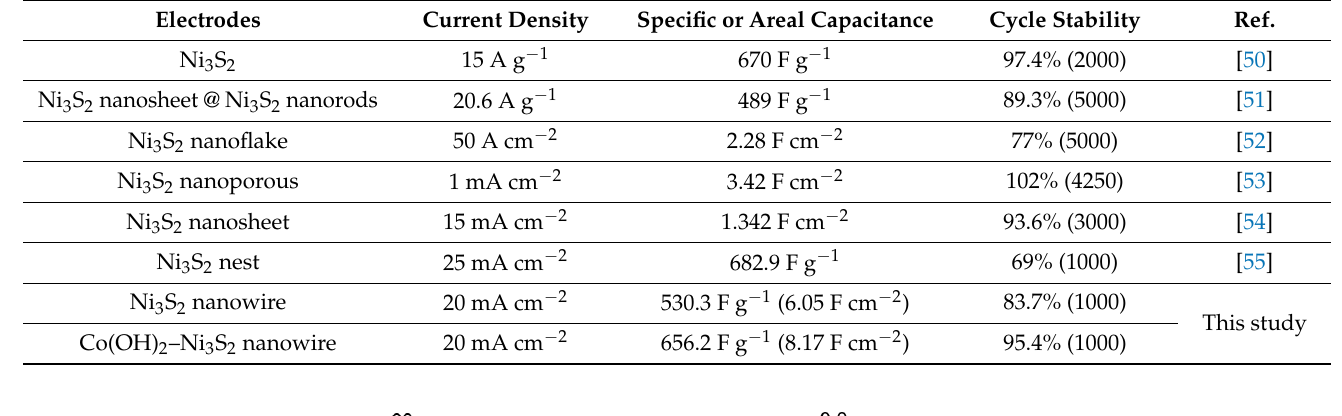
Table 1. Comparison of the electrochemical energy storage performances observed in this study with those of previously reported Ni 3 S 2 electrodes. Electrodes Current Density Specific or Areal Capacitance Cycle Stability Ref.